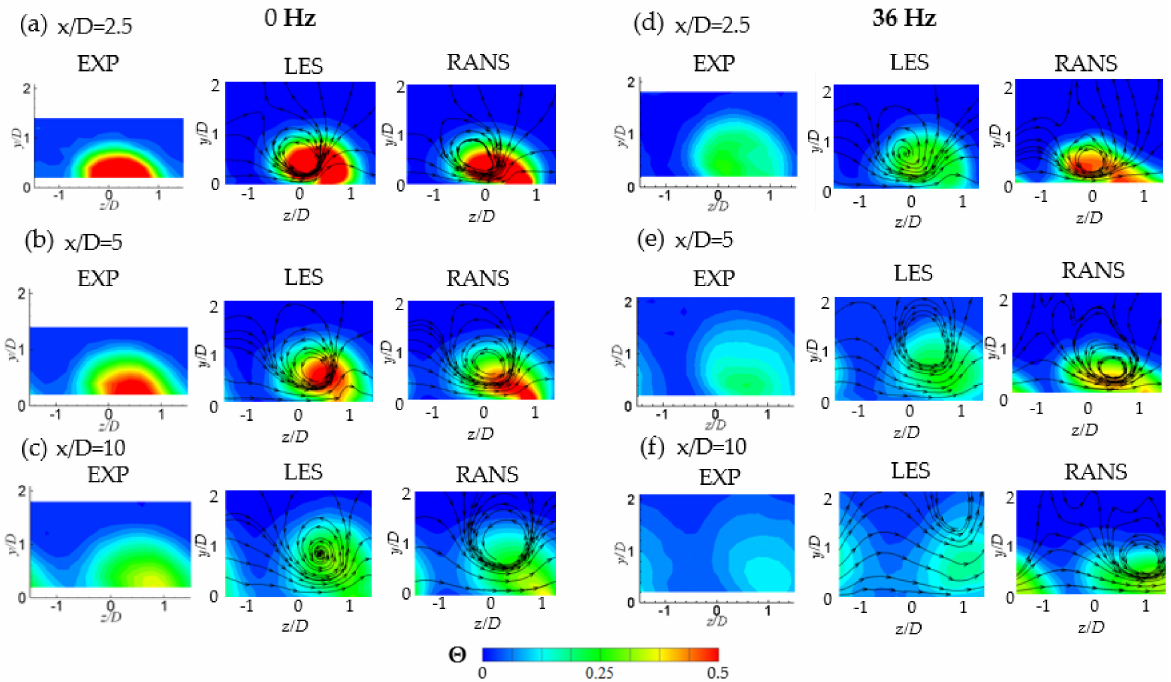
Figure 9. Time-averaged dimensionless temperature contours and streamlines for the orientation angle of 30 ◦ on the plane of x/D = 2.5, 5, and 10 at steady state (0 Hz) and 36 Hz